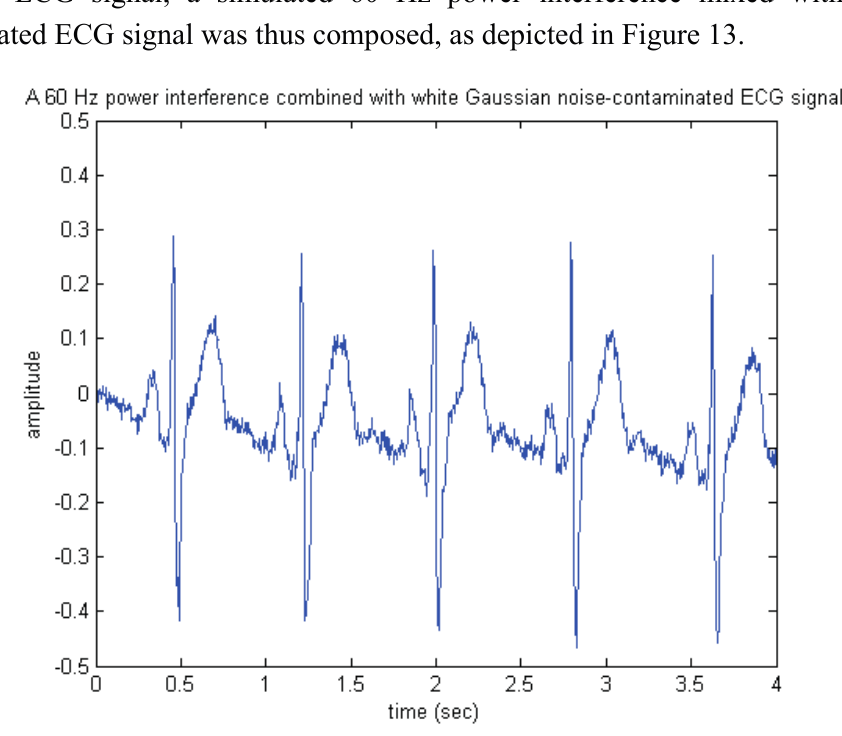
Figure 13. A simulated 60 Hz power interference mixed with white Gaussian noise-contaminated ECG